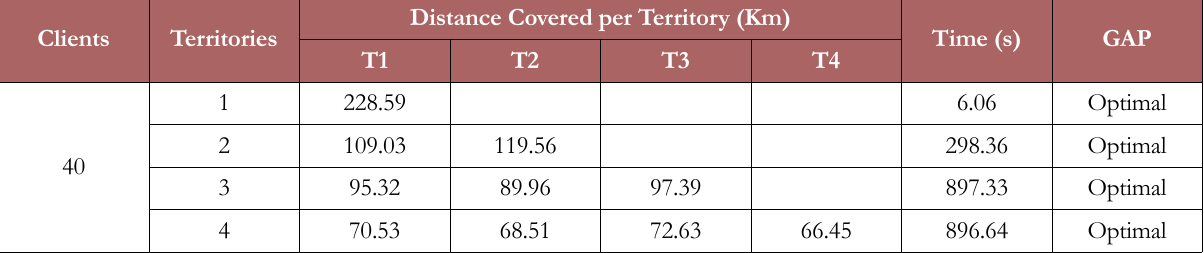
Table 4. Case study